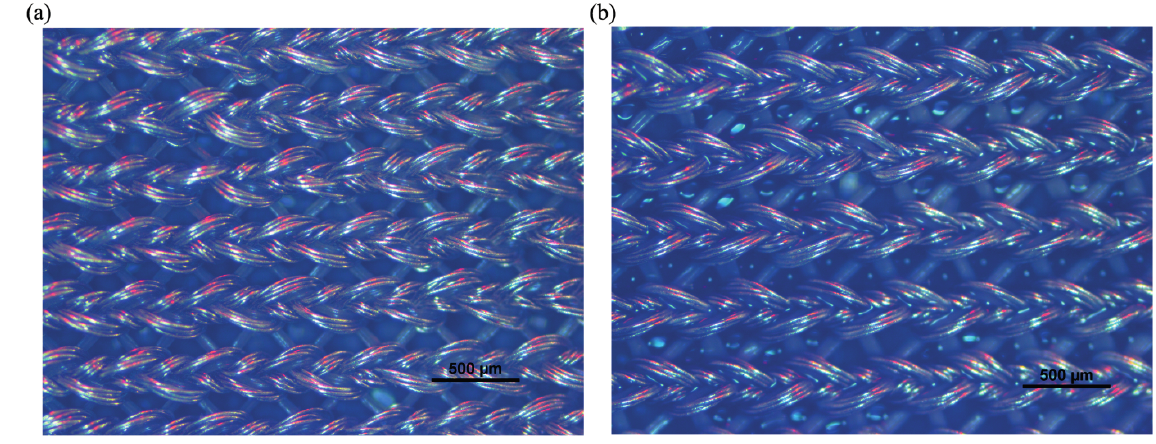
Figure 3. Microscopic view of two textile electrodes: ( a ) the dry textile electrode; ( b ) the wet textile